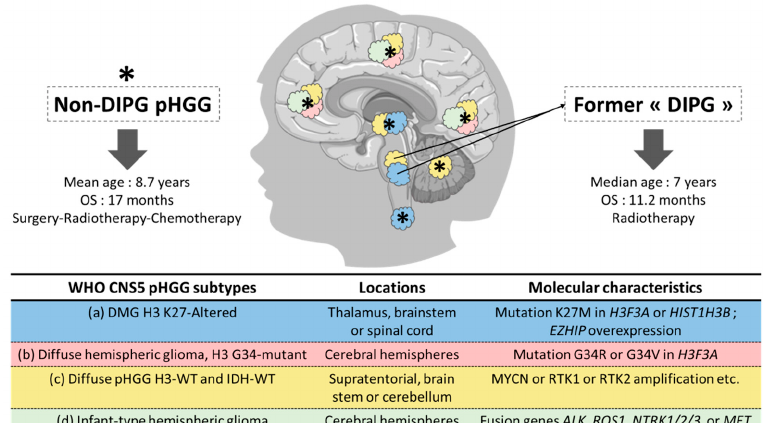
Figure 1. Clinical and molecular characteristics of the four pHGG subtypes according to the WHO CNS5 classification.The recent Fifth edition of the WHO Classification of Tumors of the Central Nervous System has defined, among the dedicated Pediatric-type high-grade gliomas (pHGG) entity, four histomolecular subtypes: (a) the Diffuse midline glioma H3 K27-altered (blue), (b) the Diffuse hemispheric glioma, H3 G34-mutant (red), (c) the Diffuse pediatric-type high-grade glioma, H3-wildtype and IDH-wildtype (yellow) and (d) the Infant-type hemispheric glioma (grey). Most of the published data were reported before this recent classification and classically divided the pHGG between diffuse intrinsic pontine glioma (DIPG) and non-DIPG tumors, based on their location. The correspondence between the former, location-based, and the current, histomolecular-based classifica- tion is represented on the sagittal brain section using a color code. Abbreviations: ALK: anaplastic lymphoma kinase; DIPG: diffuse intrinsic pontine glioma; DMG: diffuse midline glioma; EZHIP: EZH inhibitory protein; H3: histone H3; H3F3A : gene encoding H3.3; HIST1H3B : gene encoding H3.1; IDH: isocitrate dehydrogenase; MET: MET proto-oncogene, receptor tyrosine kinase; NA: non-applicable; NTRK1/2/3: neurotrophic receptor tyrosine kinase 1/2/3; OS: overall survival; pHGG: pediatric-type high-grade glioma; ROS1: ROS Proto-Oncogene 1, receptor tyrosine kinase; WHO CNS5: fifth edition of the WHO Classification of Tumors of the Central Nervous System; WT: wildtype. The schematic art pieces used in this figure were provided by Servier Medical art (https://smart.servier.com), 25 April 2022. Servier Medical Art by Servier is licensed under a Creative Commons Attribution 3.0 Unported